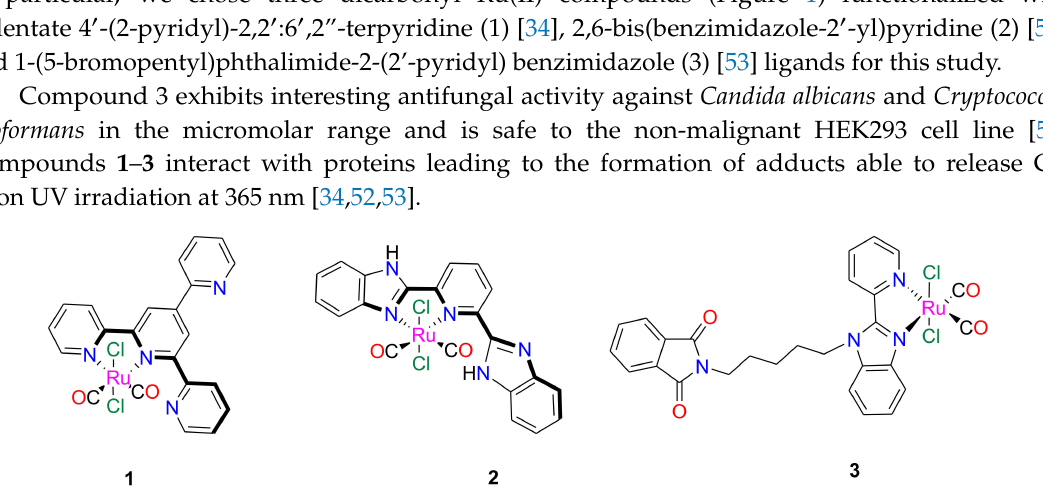
Chemical structures of the Ru(II)-based PhotoCORMs investigated in this study. CORMS = carbon monoxide-releasing